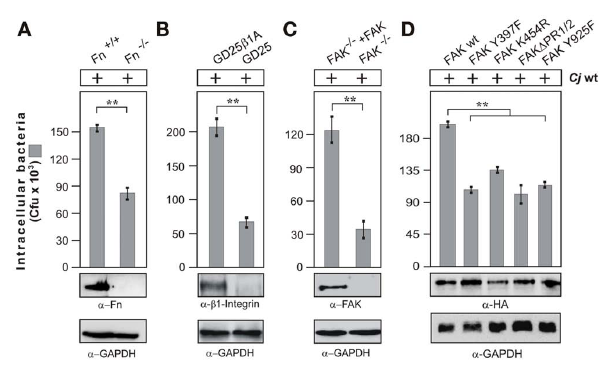
FIGURE 2 | Importance of fibronectin, integrin β 1, and FAK expression on C. jejuni invasion. The following cells lines were infected withWT C. jejuni 81–176 for 6h. (A) Fibronectin-deficient cells (Fn − / − ) and corresponding floxedWT cells (Fn + / + ), (B) integrin β 1-deficient cells (GD25) and GD25 stably re-expressingWT integrin β 1A (GD25- β 1A) cells, and (C) FAK-deficient cells (FAK − / − ) and FAK − / − cells stably re-expressingWT FAK. (D) FAK − / − cells transiently transfected with the indicated HA-tagged FAK constructs. Intracellular Campylobacter cells were quantified by gentamicin protection assays. ∗∗ p ≤ 0.005 was considered as statistically significant. Fibronectin, integrin β 1, and FAK expression was analyzed by immunoblotting. Expression of the individual FAK constructs was verified using α -HA antibody. GAPDH expression levels were determined as loading